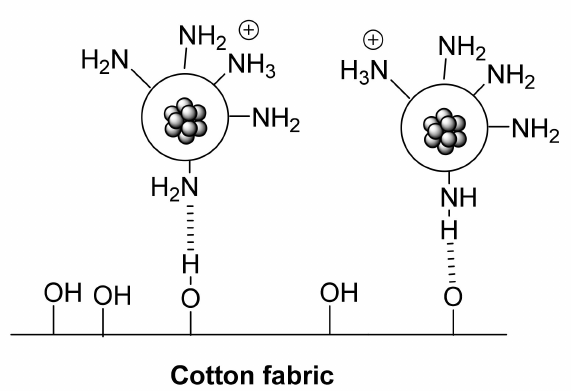
Figure 1. Possible mechanism of self-assembly of homogeneous hyperbranched poly(amide-amine) (HBPAA)-capped NPs of Ag, Au and Pt on cotton